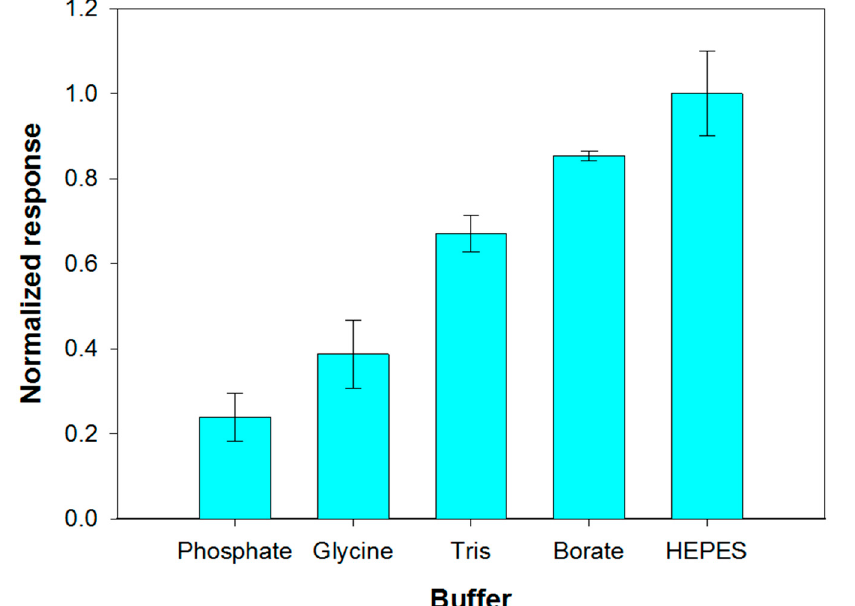
Figure 4. E ff ect of bu ff er composition (pH 8.0, I 0.05 M) on choline biosensor response to PLD 0.22 IU / mL. Figure 4. Effect of buffer composition (pH 8.0, I 0.05 M) on choline biosensor response to Triton X-100 concentration: 0.75% (v / v). Calcium chloride concentration: 0.2 mM. Phosphatidylcholine PLD 0.22 IU/mL. Triton X-100 concentration: 0.75% (v/v). Calcium chloride concentration: concentration: 5 mM. Electrode rotation rate: 200 rpm. Each value represents the mean of triplicate 0.2 mM. Phosphatidylcholine concentration: 5 mM. Electrode rotation rate: 200 rpm. Each measurements; the error bars represent the relevant standard value represents the mean of triplicate measurements; the error bars represent the relevant